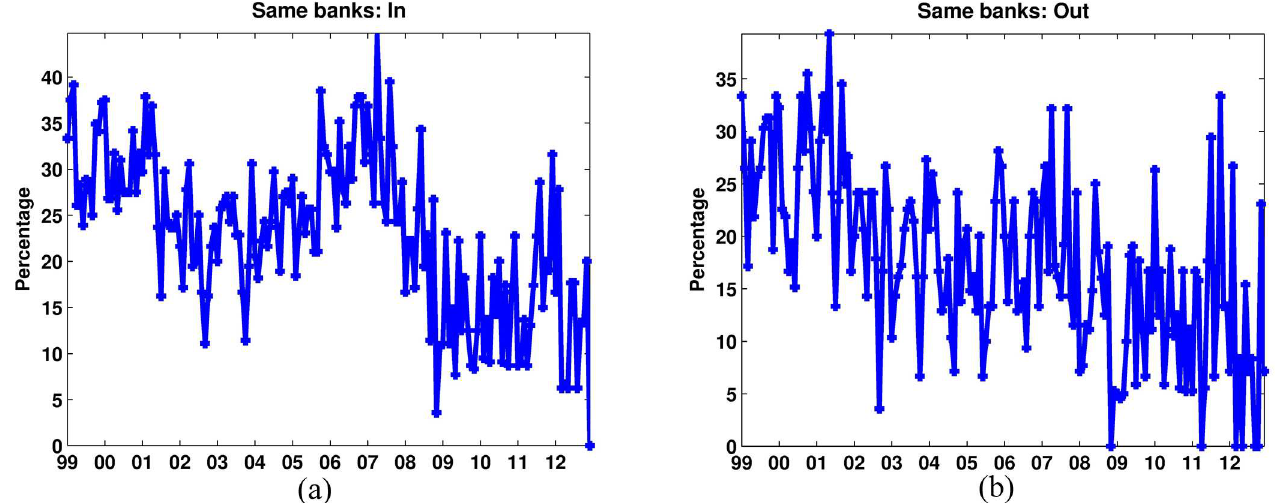
Fig 5. NMF method vs weighted degree measures. Panel (a) shows the percentageof banks identified as SIBs (SIFIs for the borrowing component)by both methods. Panel (b) shows the percentageof banks identified as SILs (SIFIs for the lendingcomponent) by both